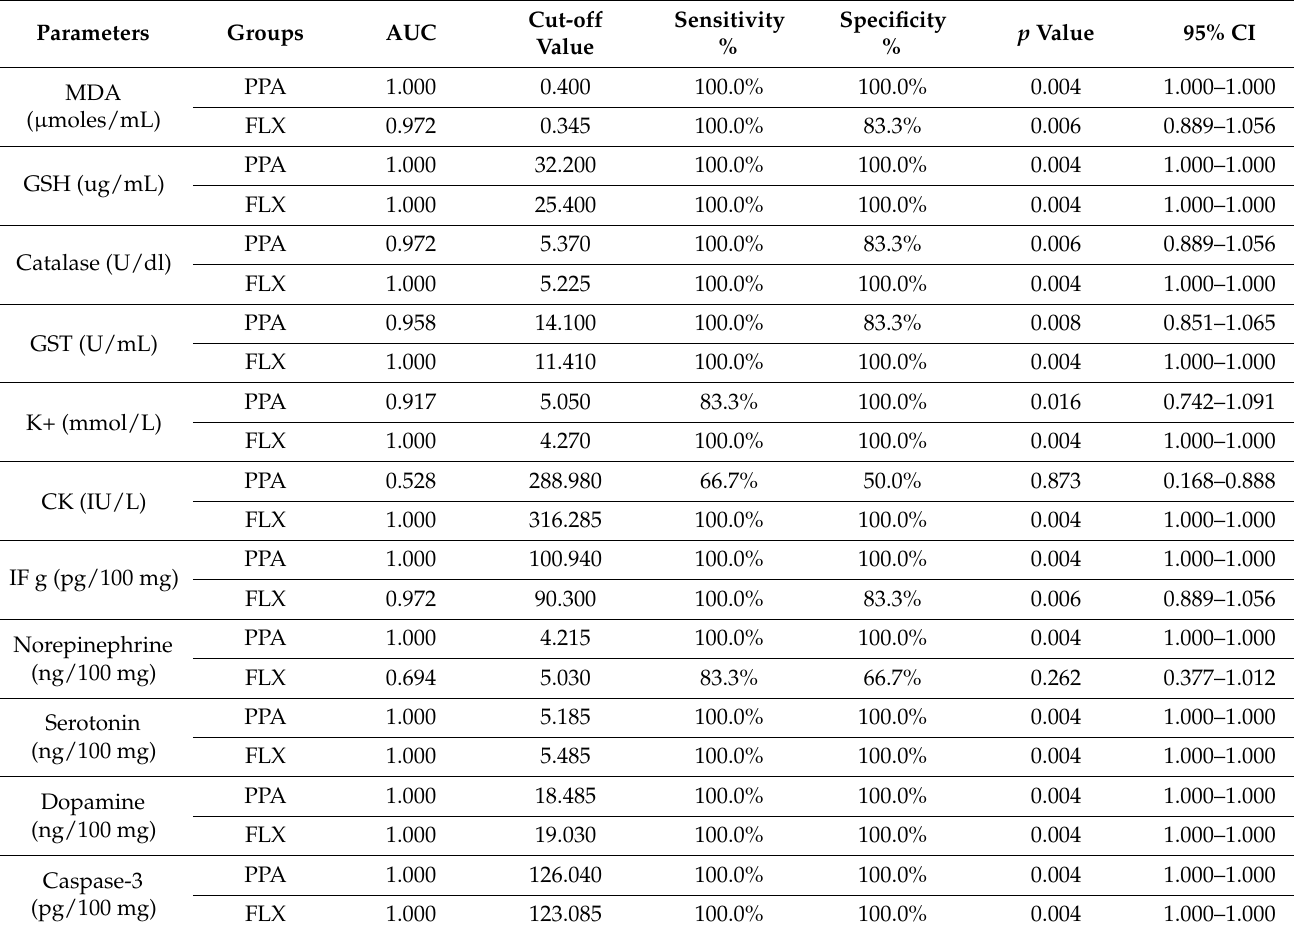
Table 3. ROC curve of all parameters in all